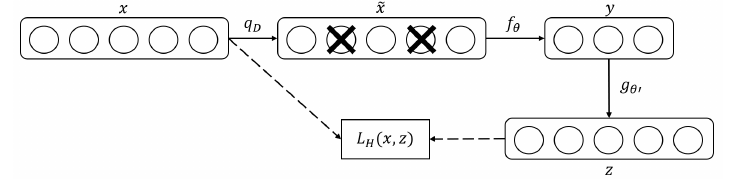
Figure 2. Denoise